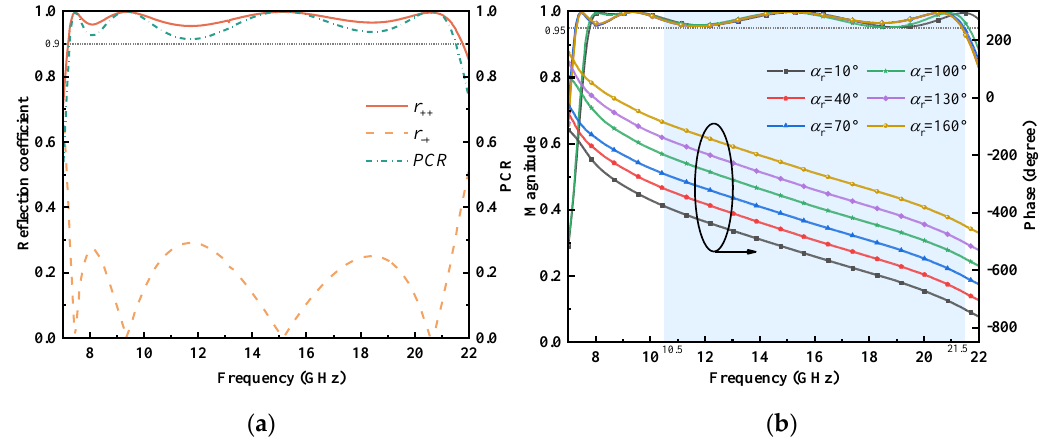
Figure 3. Simulation results of the proposed PB meta-atom. ( a ) Reflection coefficient and PCR of r ++ . ( b ) The magnitude and phase of r ++ at different rotating angles.